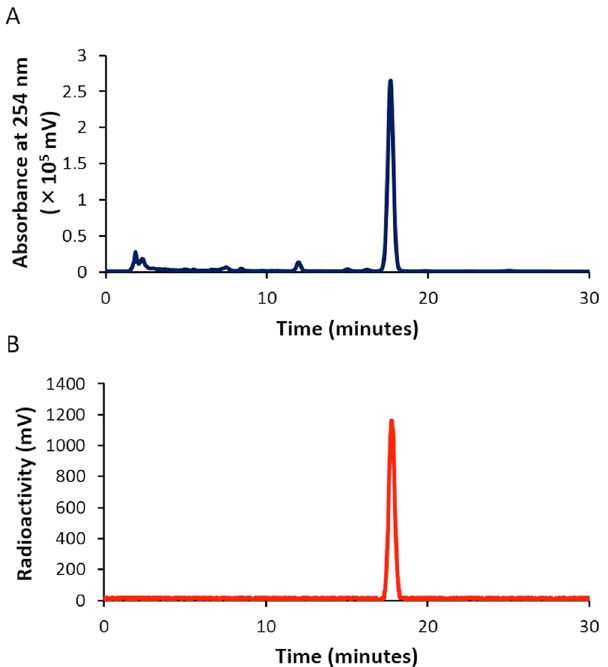
Figure 8. HPLC profiles of 4 (absorbance at 254 nm, A ) and [ 125 I] 4 (radioactivity,